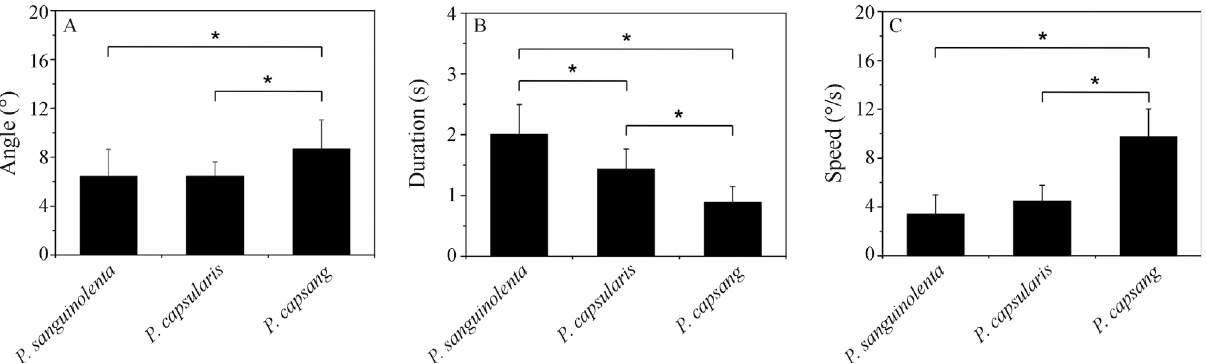
Figure 4 - Movement dynamics of the androgynophore of P. capsularis , P. sanguinolenta and their interspecific hybrid P. ‘capsang’. (A) Movement am- plitude measured by the angle formed between the initial state (before the movement) and the final state (after the movement) in degrees. (B) Duration of the movement in seconds. (C) Angular speed of the movement in deg/s. Data represent means (cid:2) SD. Asterisks indicate statistical differences between ge- notypes (Kruskal-Wallis